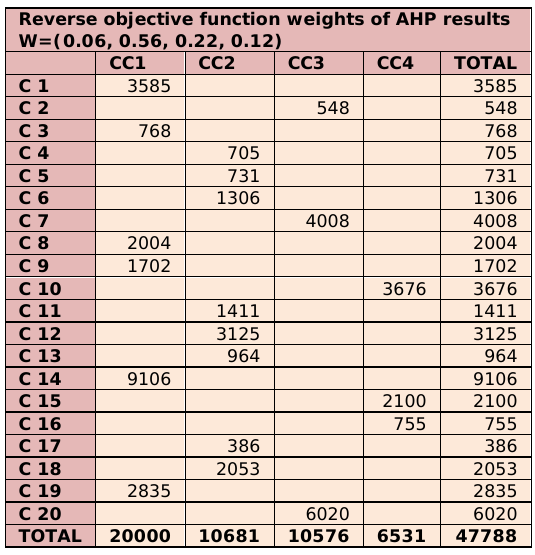
Table 6. Flows between customers and collection centers. Reserve objective function weights